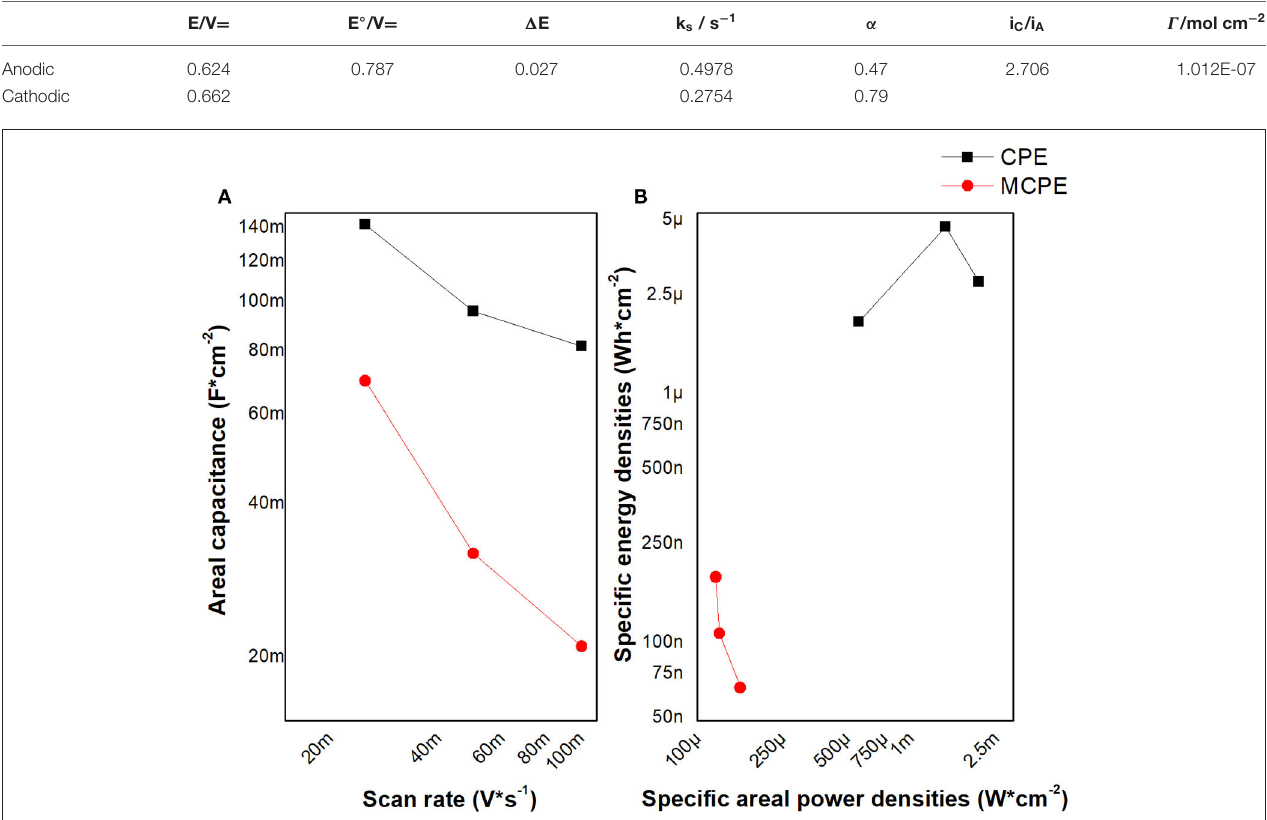
FIGURE 8 | The electrochemical performance of the MCPE using voltammetry data, (A) response of the specific areal Capacitance vs. Scan rate and (B) the Ragone plot of the electrochemical